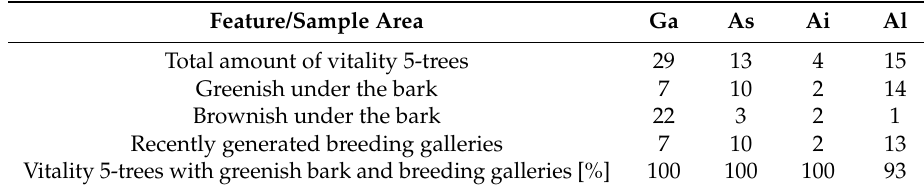
Table 6. In four ash stands (Gaden (Ga), Aschheim (As), Aidenbach (Ai) and Albersdorf (Al)) the number of dead trees were counted and examined for gallery